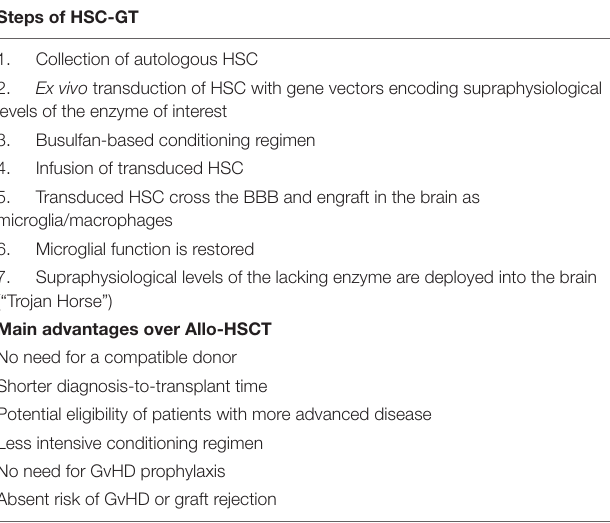
TABLE 3 | Steps of hematopoietic stem cell gene therapy and main advantages over Allo-HSCT in IEM with neurological involvement. Steps of